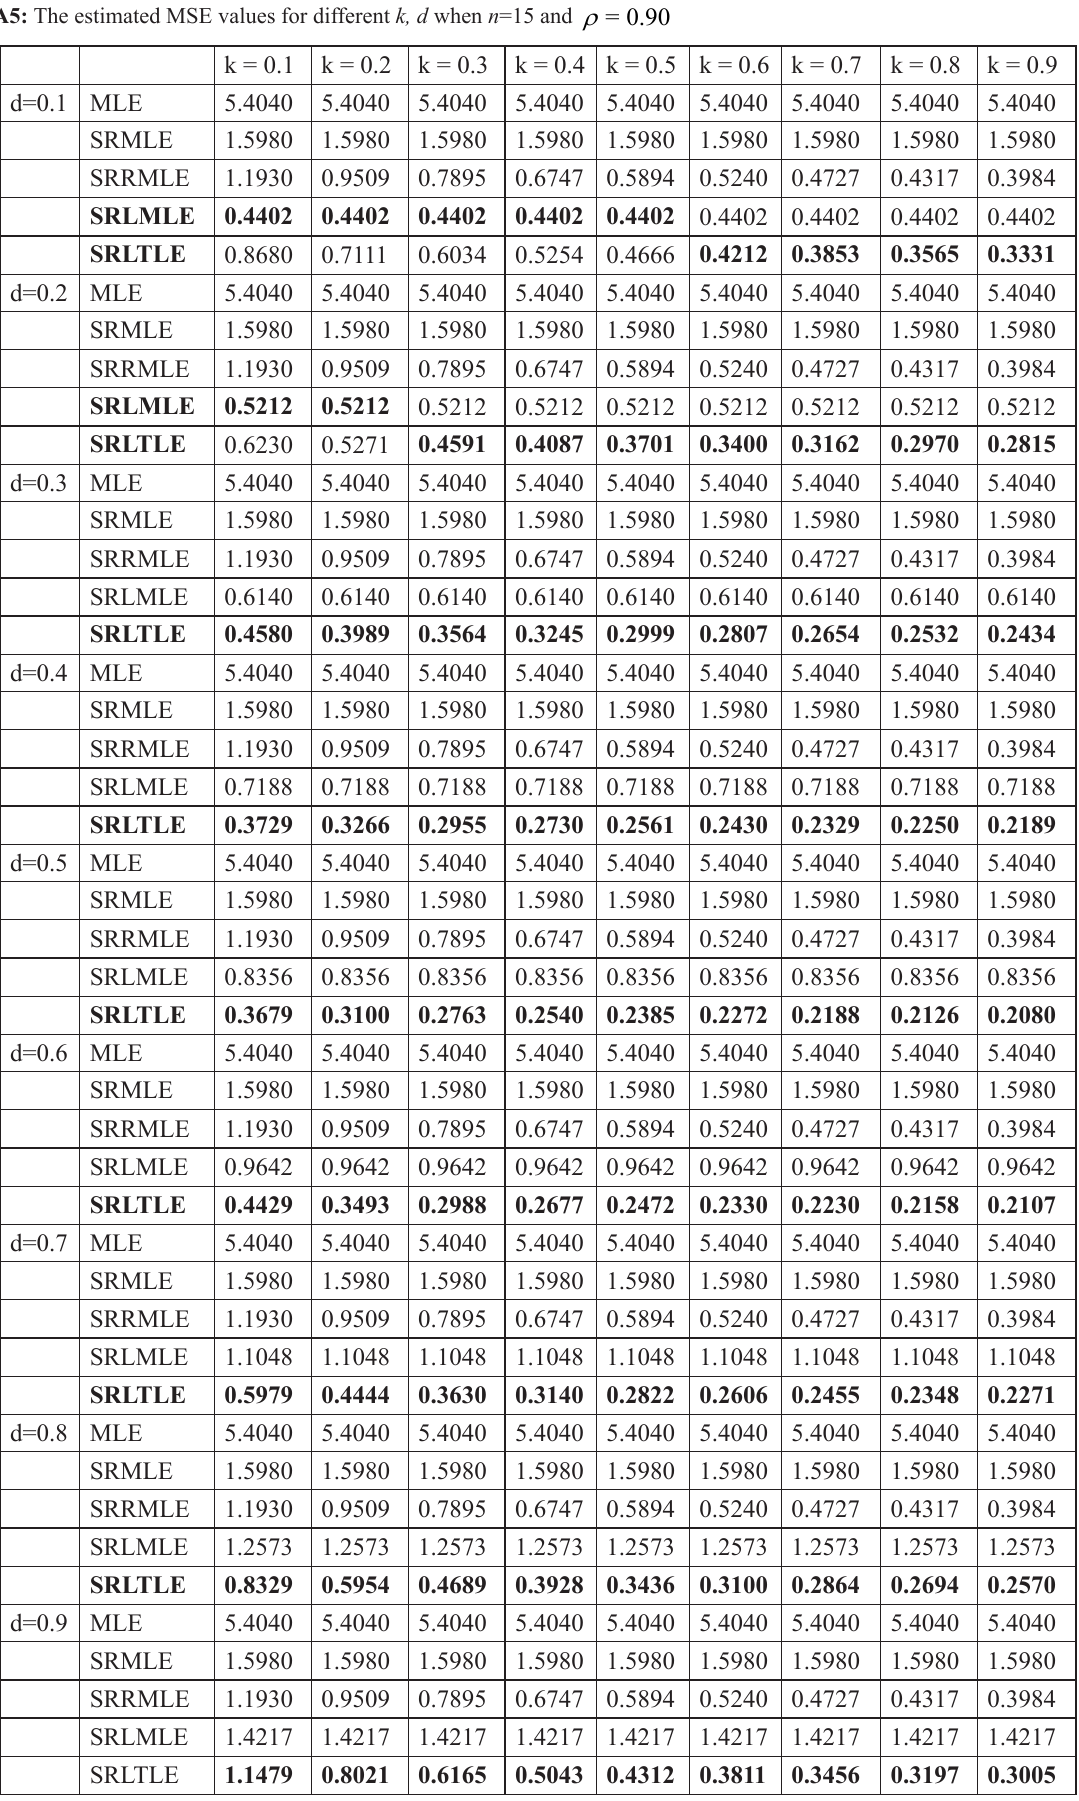
Table A5: The estimated MSE values for different k, d when n =15